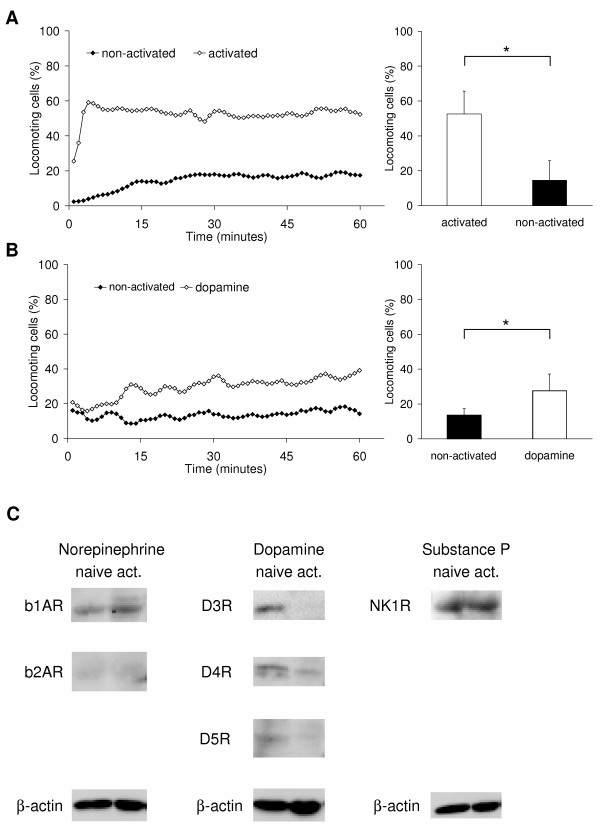
Migratory activity of CD8+ T lymphocytes. Each graph shows on the left side the time-course of the mean migratory activity and on the right side the time-average of the migratory activity as mean value and standard deviation of the same experiments. In (A), nine experiments were performed with activated and naive CD8+ T lymphocytes, in (B) four experiments were performed with naïve CD8+ T lymphocytes (1 μM dopamine). For each experiment, blood from different donors was used. Asterisks mark statistically significant changes (p < 0.05). (C) Shows the western blot analysis of the neurotransmitter receptors expressed on naïve and activated CD8+ T lymphocytes. β-Actin served as loading control.